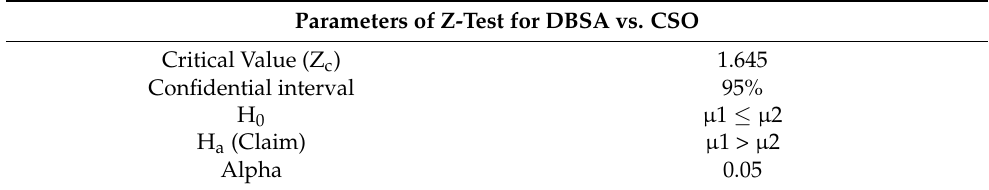
Table 16. Parameters used in Z-Test for DBSA vs. CSO.